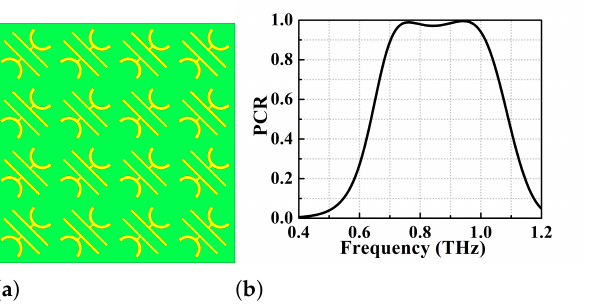
Figure 3. ( a ) Schematic of periodic arrangement of the metasurface unit cell ( b ) polarisation conver- sion efficiency analysis of the proposed metasurface corresponding to l 1 = 117 µ m.